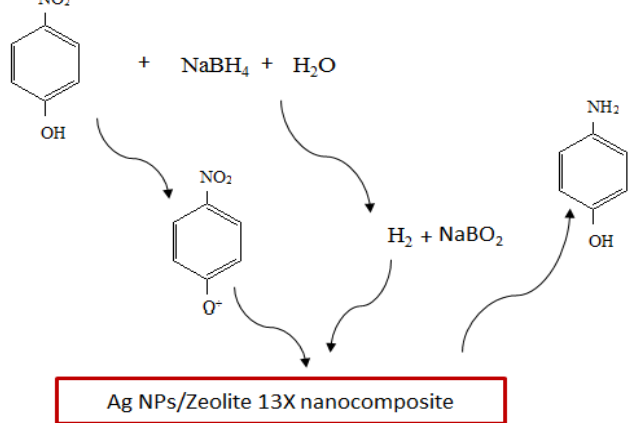
Fig. 10. The UV-Vis spectra of 4-NP aqueous solution in the presence of NaBH and Ag NPs/Zeolite 13X nanocomposite 4 Fig. 10 The UV-Vis spectra of 4-NP aqueous solution in the presence of NaBH 4 and Ag NPs/Zeolite 13X nanocomposite .